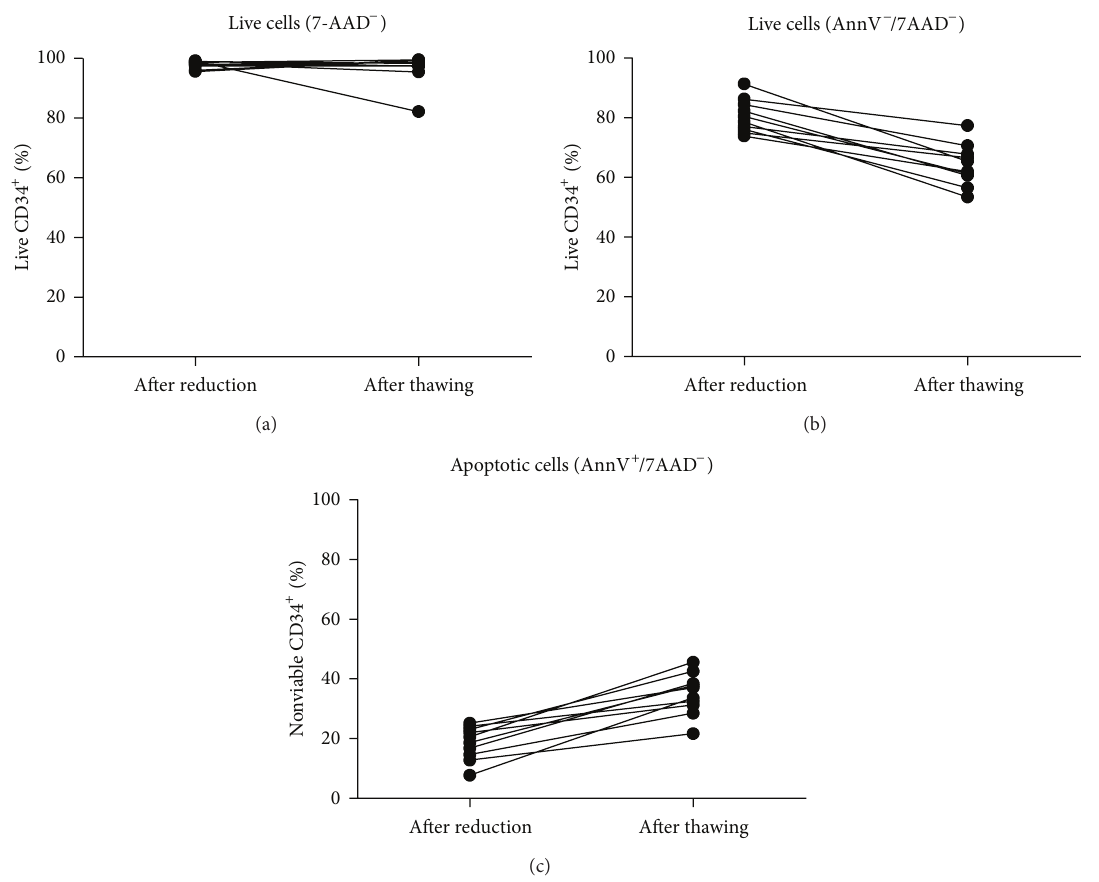
Figure 1: (a) Staining with solely 7-AAD, as in the ISHAGE protocol, showed only low amounts of dead CD3 4 + cells following the volume reduction as well as thawing. ((b), (c)) Combination of 7-AAD with Annexin V revealed already remarkable amounts of apoptotic cells in processed samples ahead of cryopreservation which increases furthermore after thawing. Only cells negative for 7-AAD as well as Annexin V could be regarded as fully